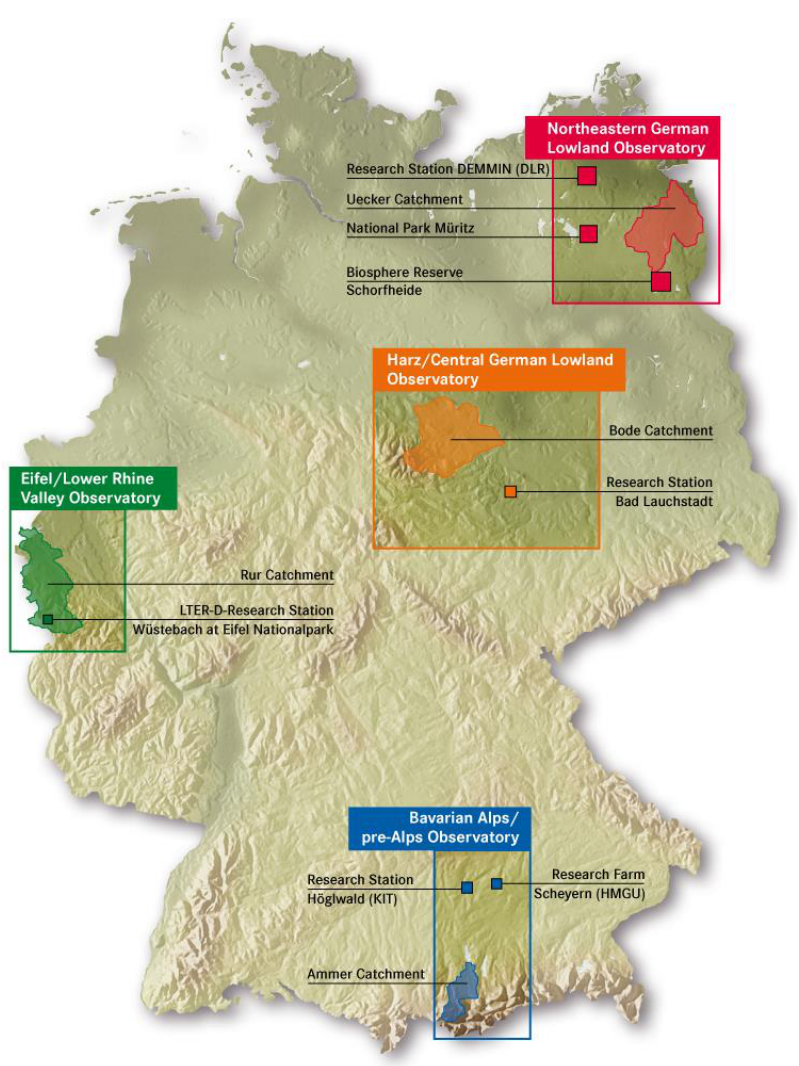
Figure 1: Map of Germany, indicating the locations of the four selected TERENO observatories, including the experimental catchments and research stations (Zacharias et al., 2011).